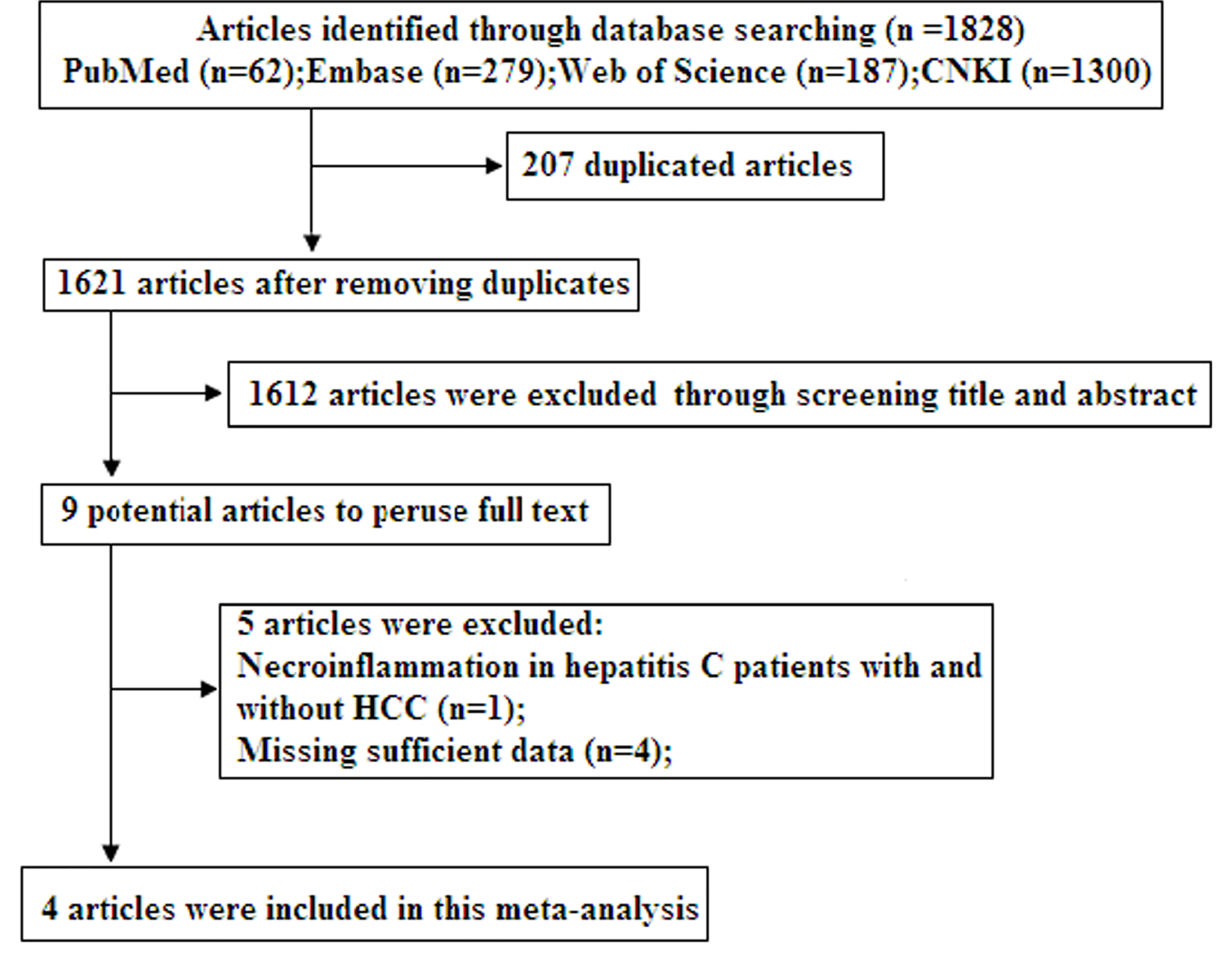
Fig 1. Flow diagram of study